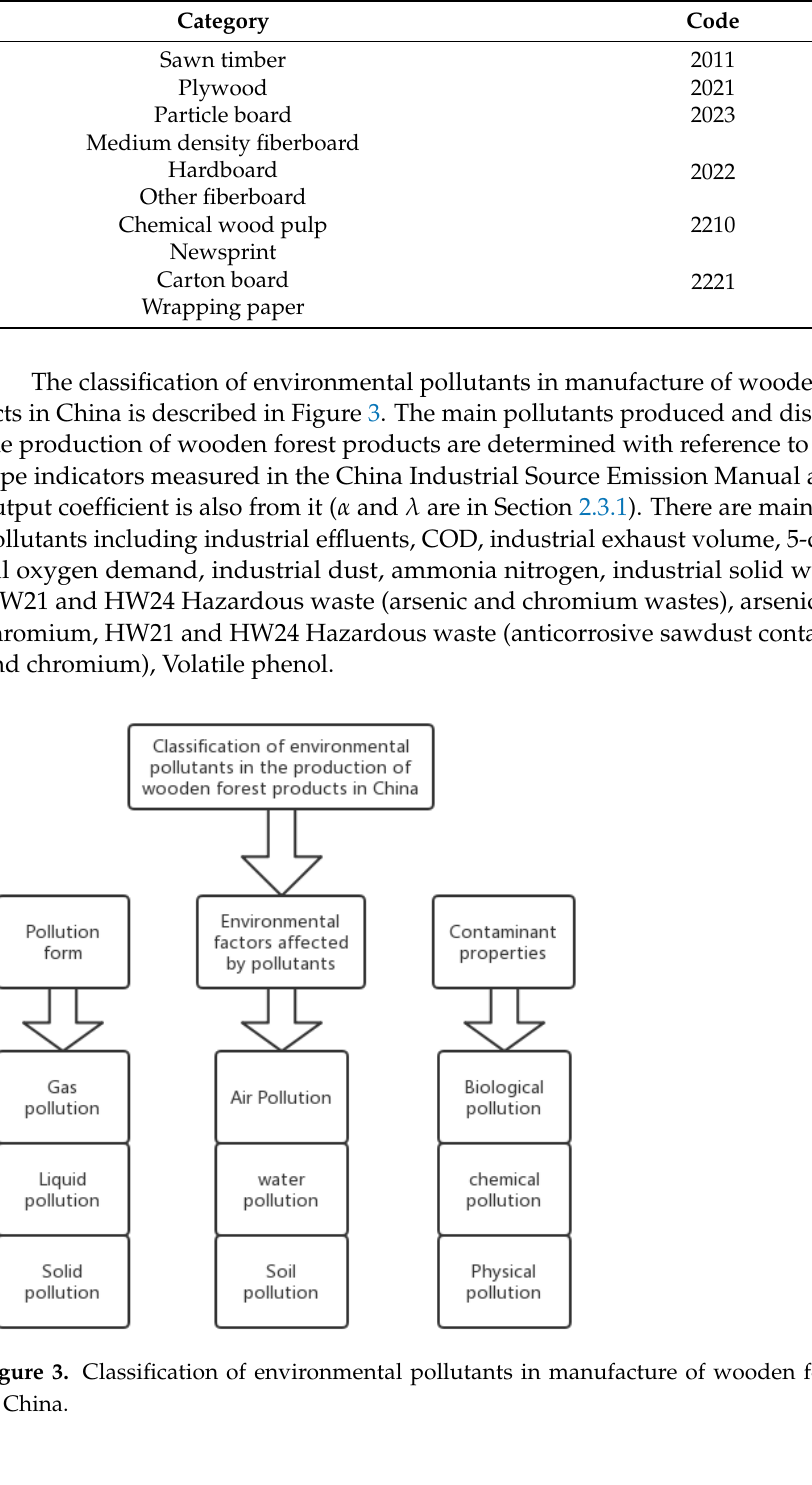
Table 3. Codes of sources of trade pollution of wooden forest products.